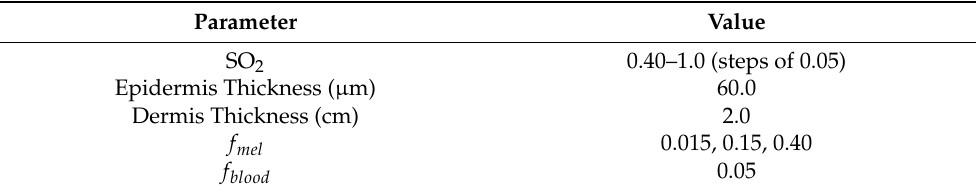
Table 1. Parameters for simulated dataset used in wavelength selection.